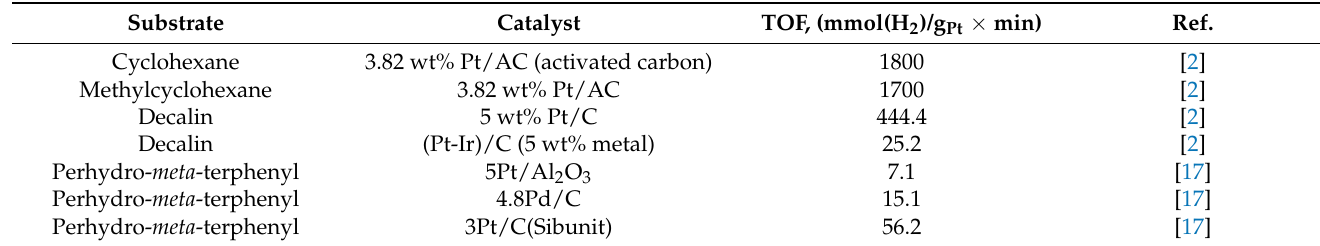
Table 1. Hydrogen release rates during dehydrogenation of some cycloalkanes.